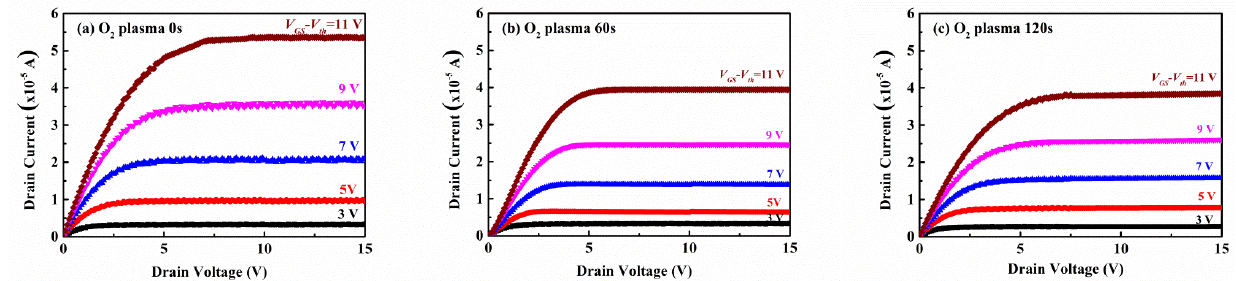
Figure 4. Output characteristics I DS - V DS of IGZO TFTs at O 2 plasma times of ( a ) 0, ( b ) 60, and ( c ) 120 s.